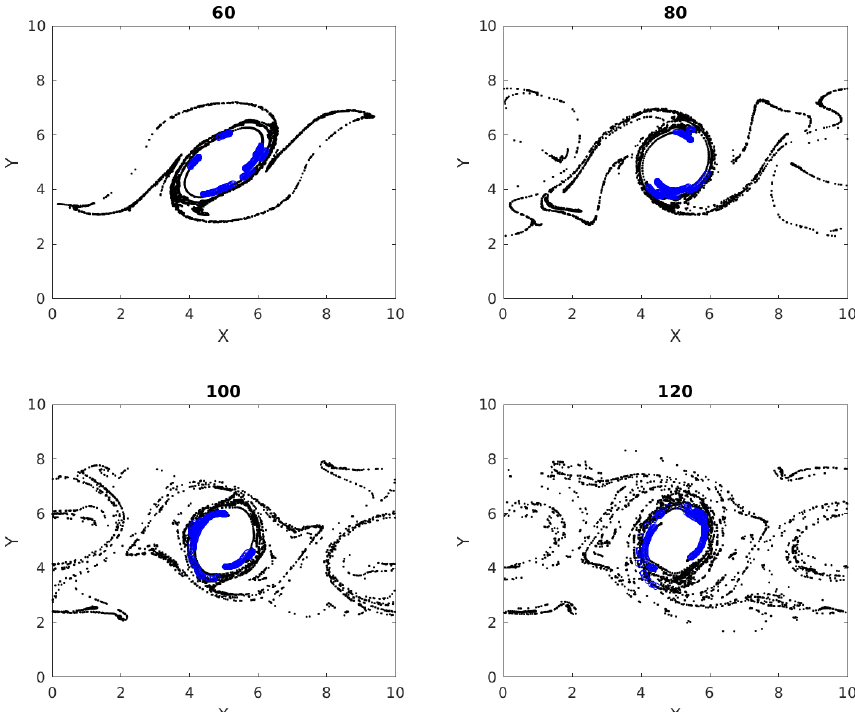
Figure 7. Multiple time images of cumulative cluster 1 (black) with its dense subclusters (blue). Blue circles at later times represent particles that were parts of a dense subcluster at time 50.